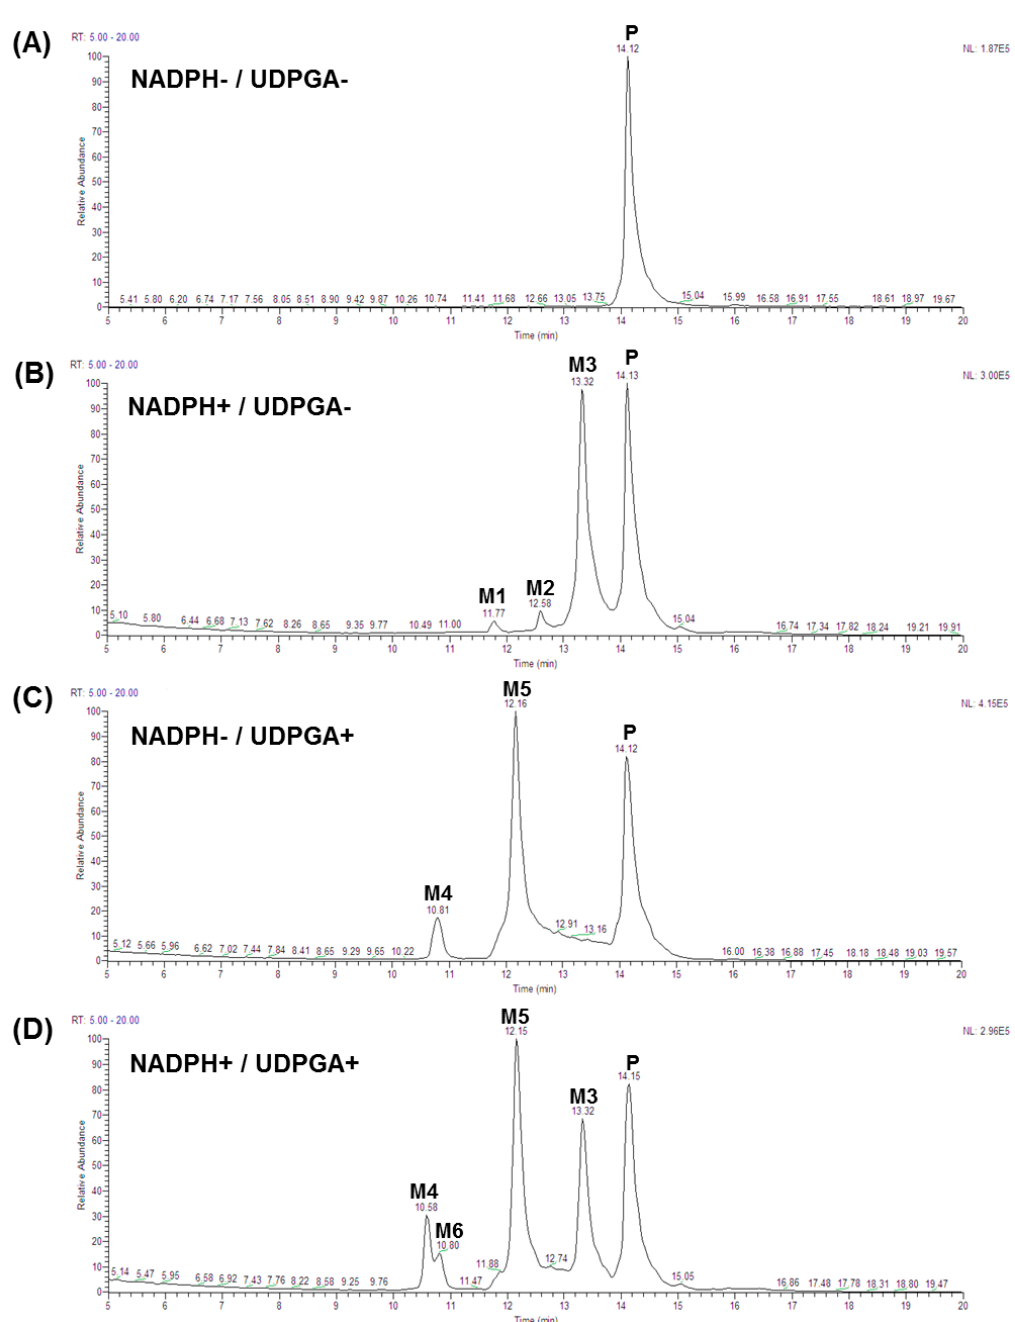
Figure 1. Total ion chromatogram of metabolites of SKN that are dependent on NADPH, UDPGA, or both cofactors. Human liver microsomes were incubated with the appropriate cofactor(s) along with SKN for 60 min. Chromatograms of the incubation mixture with SKN but without cofactors ( A ), NADPH-dependent metabolites ( B ), UPDGA-dependent metabolites ( C ), and the incubation mixture with both NADPH and UPDGA ( D ) are shown. P refers to the parent compound, SKN; whereas the metabolites are designated M1 through M6. The metabolites are identified in Table 3.